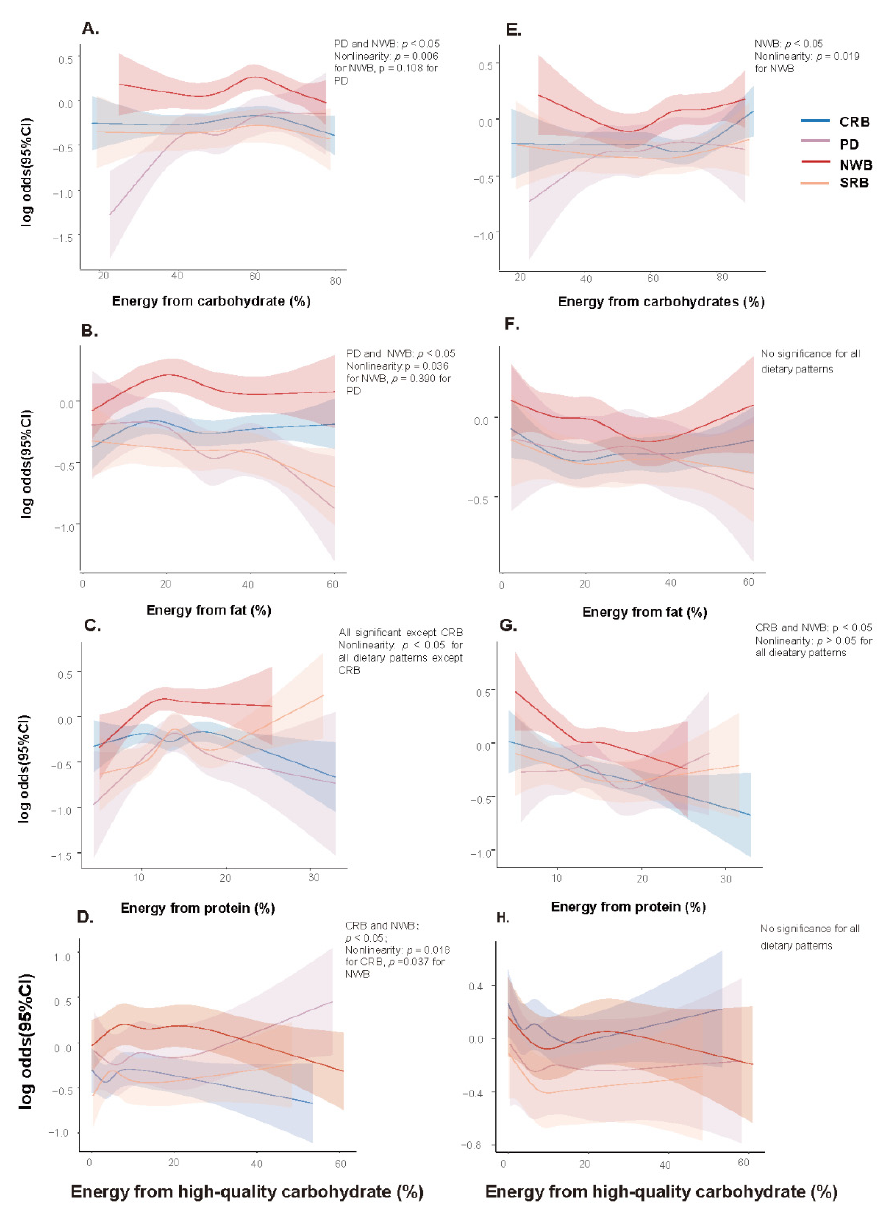
Figure 6. Associations between estimated percentage energy from macronutrients and over ‐ weight/obesity and hypertension stratified by dietary patterns. ( A – D ): overweight/obesity; ( E – H ): hypertension. All models were adjusted for sex, age, ethnic group, education level, household in ‐ come per capita, occupation, smoking behavior, drinking behavior, physical activity, total energy intake, and family history of cardiovascular disease and diabetes. For hypertension, body mass in ‐ dex was adjusted in addition. CRB: Common rice ‐ based dietary pattern; PD, prudent diversified dietary pattern; NWB, northern wheat ‐ based dietary pattern; SRB, southern rice ‐ based dietary pat ‐ tern. For overweight/obesity, p interaction < 0.01 for carbohydrate, fat and protein, and p interaction = 0.015 for high ‐ quality carbohydrate; for hypertension, p interaction < 0.05 for percentage energy from carbo ‐ hydrate and fat and p interaction > 0.05 for protein and high ‐ quality carbohydrate.